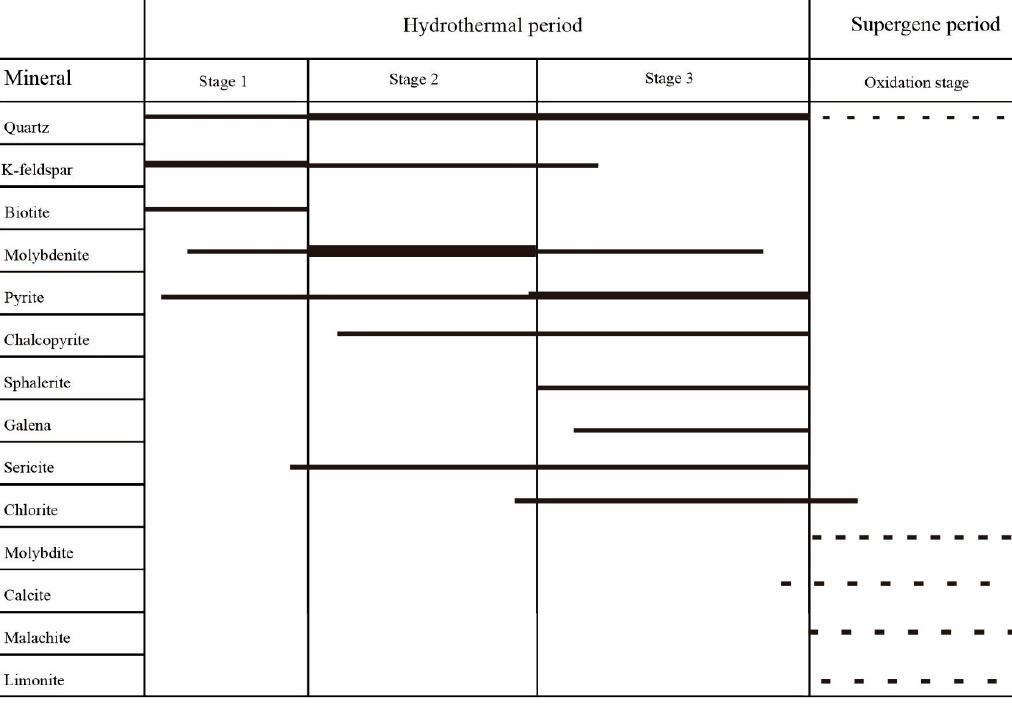
Figure 4. Metallogenic stages and mineral paragenesis in the Reshui Mo deposit.